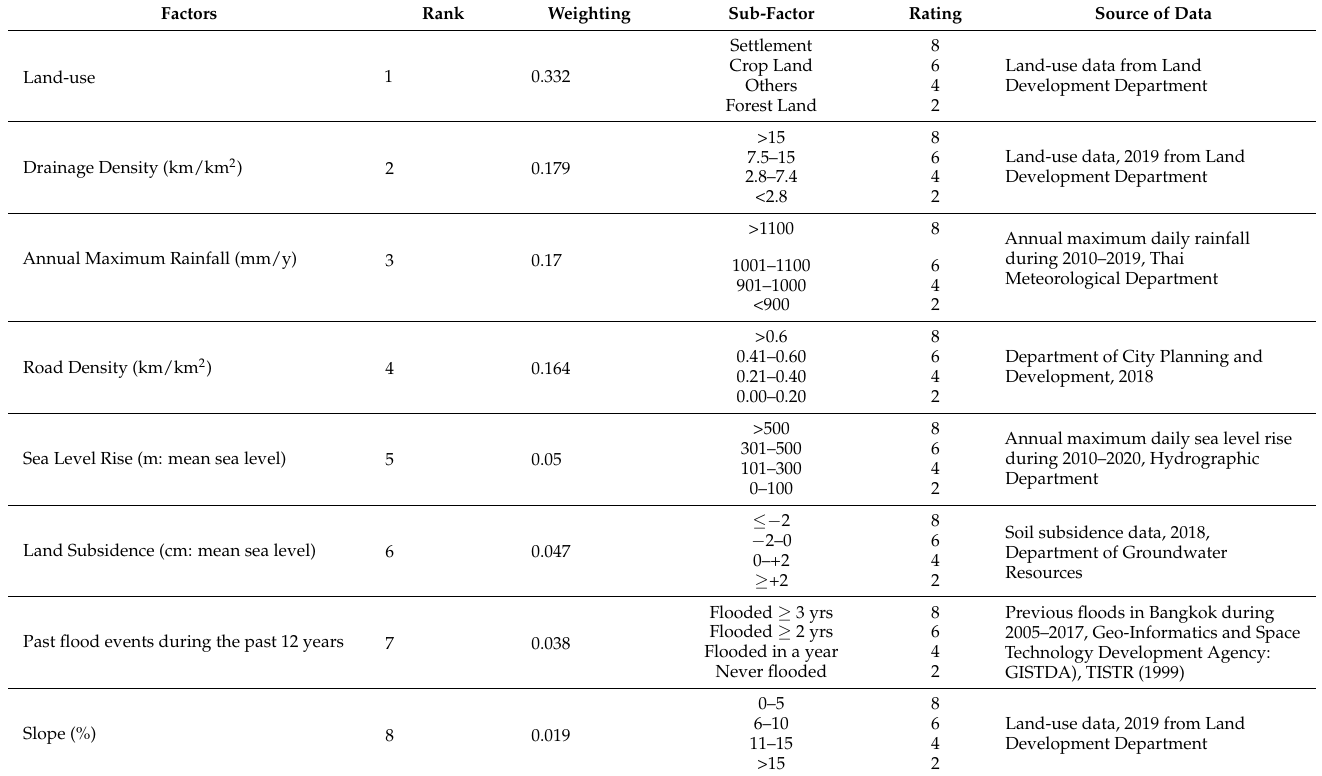
Table 2. Spatial data and weight evaluation of factors affecting the flood hazard areas in Bangkok,